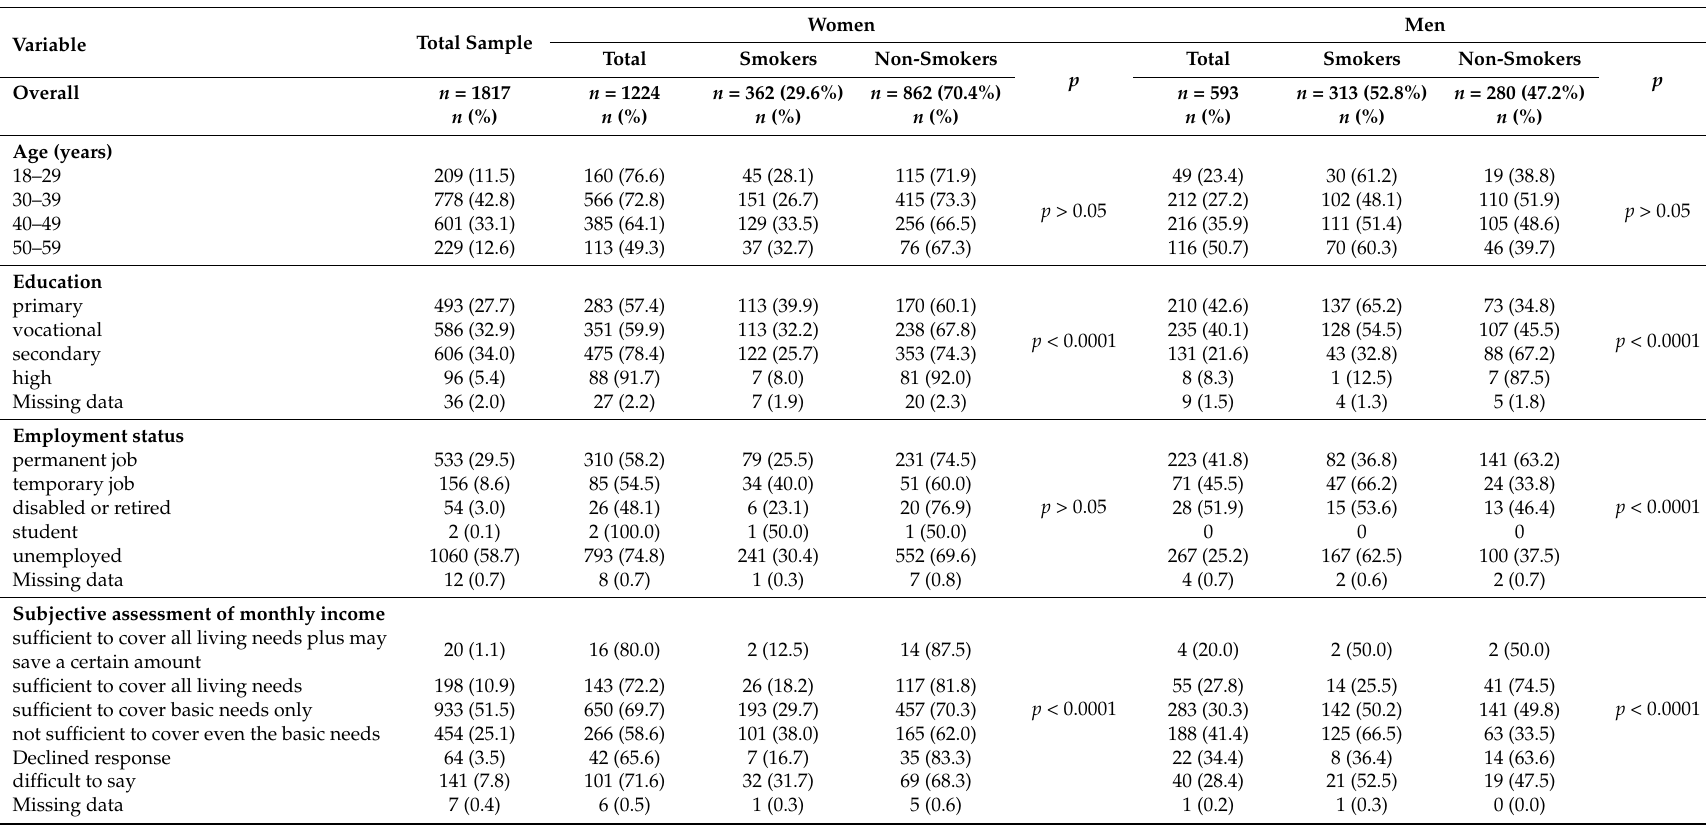
Table 1. Characteristics of study respondents n =